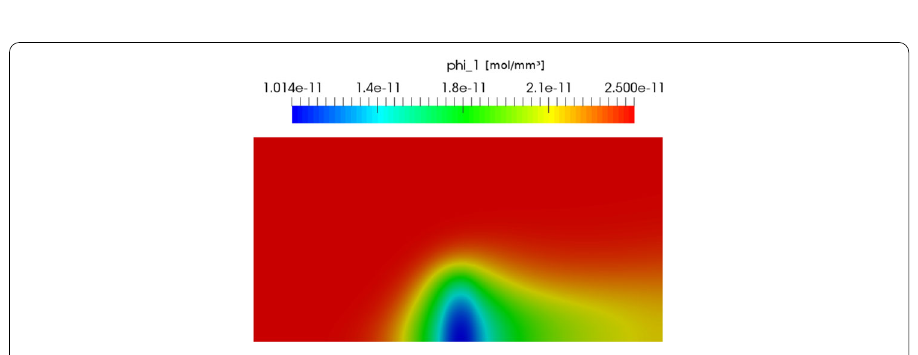
Fig. 20 Solution of the prototype nutrient concentration